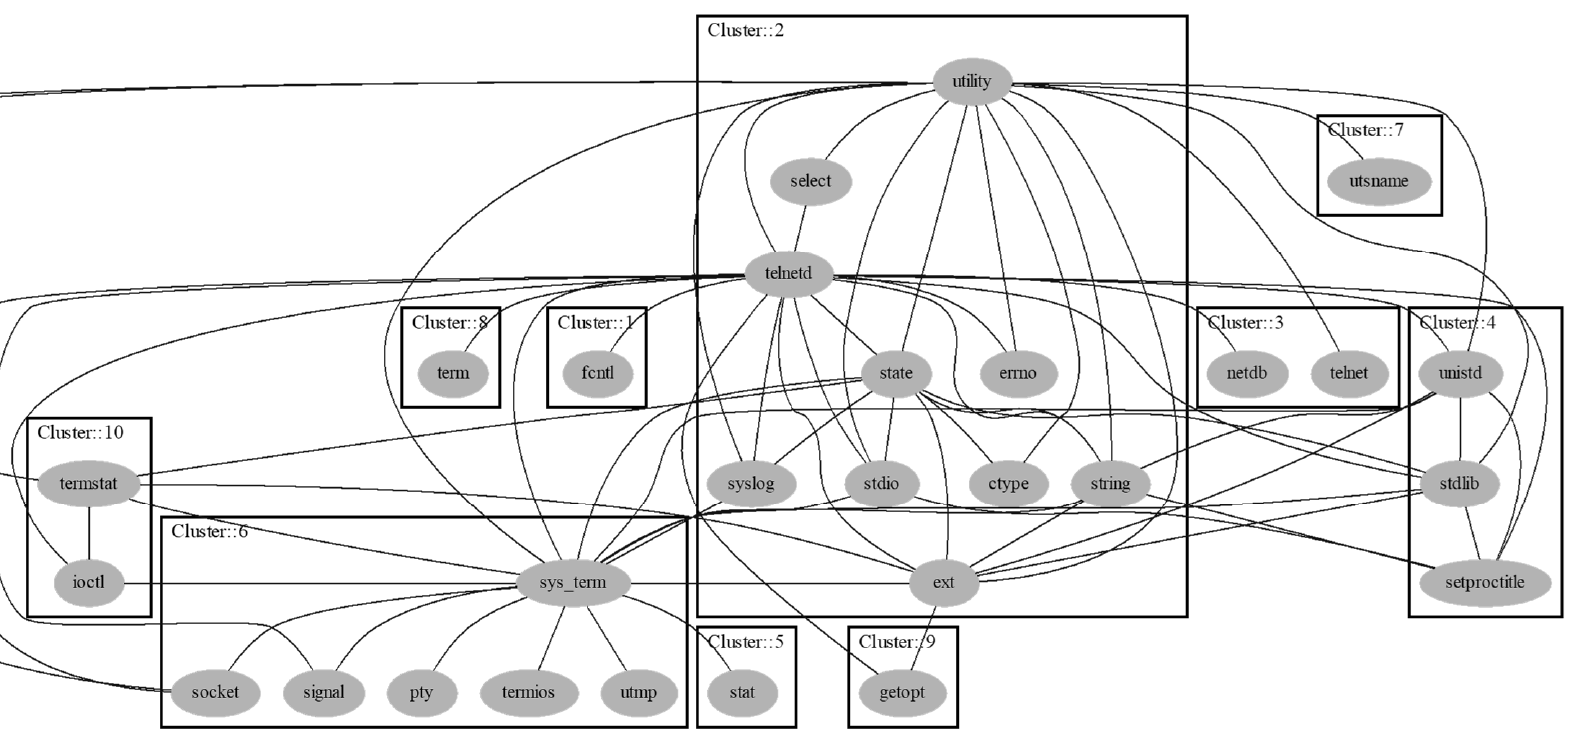
Figure 8. Telnet2 system before applying the HHMO_CF_GDA approach.